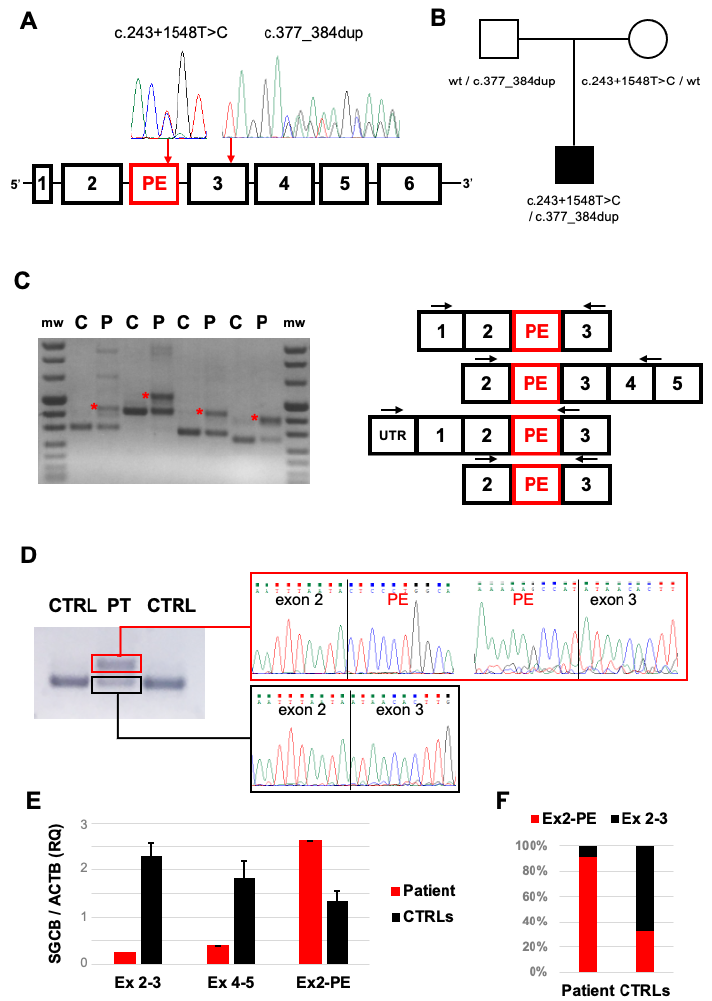
Figure 2. Molecular studies: ( A ) Scheme of SGCB gene displaying the position of the predicted pseudoexon (PE) and sequence electropherograms of heterozygous c.243+1548T>C and c.377_384dup variants identified in our patient. ( B ) Segregation analysis in the trio described in the family supporting biallelic inheritance of the SGCB variants. ( C ) RT-PCR analysis of SGCB transcripts in patient’s (P) and control (C) muscle specimens. The scheme of multiple PCR amplicons encompassing the cDNA region containing the PE is reported (arrows indicate the positions of PCR primers). ( D ) Sequence electropherograms generated from RT-PCR amplicons displaying the abnormal Exon2-PE-Exon3 junction in patient’s (P), but not control (C), muscle cDNA. ( E ) Quantitative RT-PCR experiments evaluating physiological (Ex2–Ex3, Ex4–Ex5) and abnormal (Ex2-PE) splicing junctions in muscle cDNA retrotranscribed from patient’s muscle and 3 control muscle biopsies. ( F ) Percentage of pseudoexon inclusion (Ex2-PE, red) in patient’s and control muscle biopsies estimated by qRT-PCR experiments.